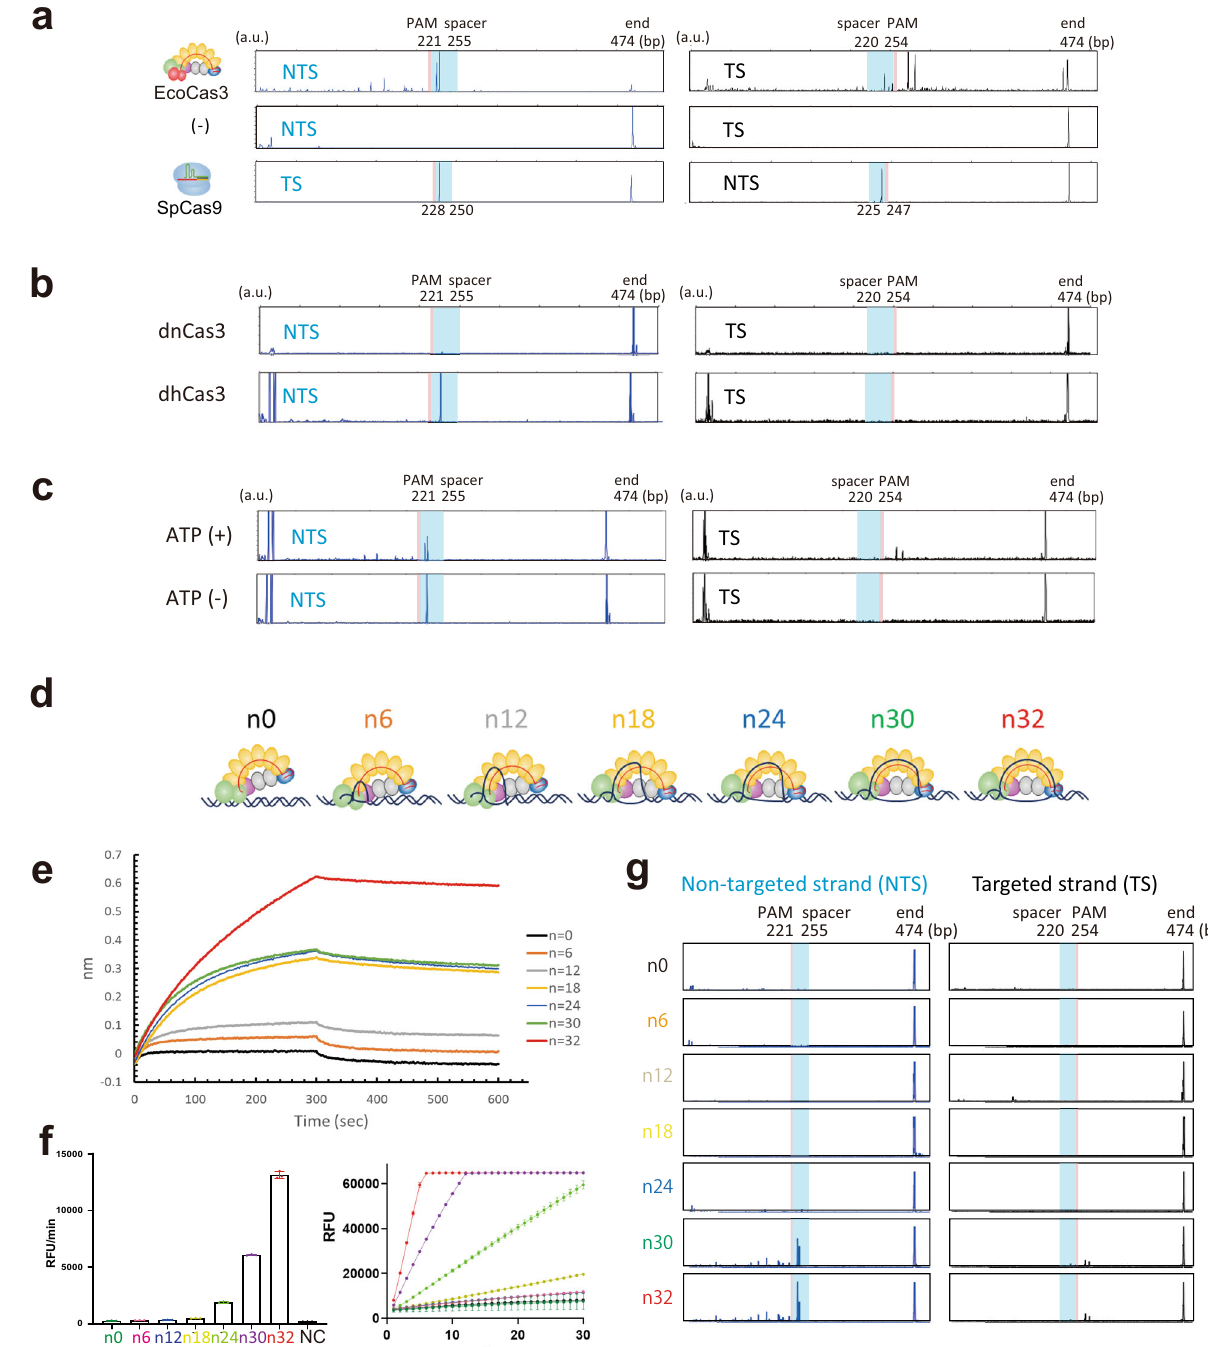
Fig. 3 | Mechanistic insight into collateral ssDNA cleavage and target DNA degradation.a Fluorescently-labeledtargetdsDNAsubstrates,5 ′ -NTS-FAM,and5 ′ - TS-TAMRA,tovisualizedsDNAcleavage.EcoCas3withEcoCascadeRNPscleavesat NTS nucleotides 10 – 11, downstream of the PAM site, with repetitive cleavage. The TScleavedrepetitivelydozensofnucleotidesupstreamofthePAM.SpCas9cleaves both NTS and TS at 3 – 4 nucleotides from the PAM. The x -axis represents the DNA fragment size in base pairs (bp), and the y-axis represents the arbitrary unit (a.u.). b The dnCas3 HD domain mutant and the dhCas3 SF2 domain mutant for the dsDNA cleavage assay. c The dsDNA cleavage assay by EcoCas3 in ATP (+) or ATP- free ( − ) reaction buffer. d Changing the size of the R-loop formation from 0 to 32